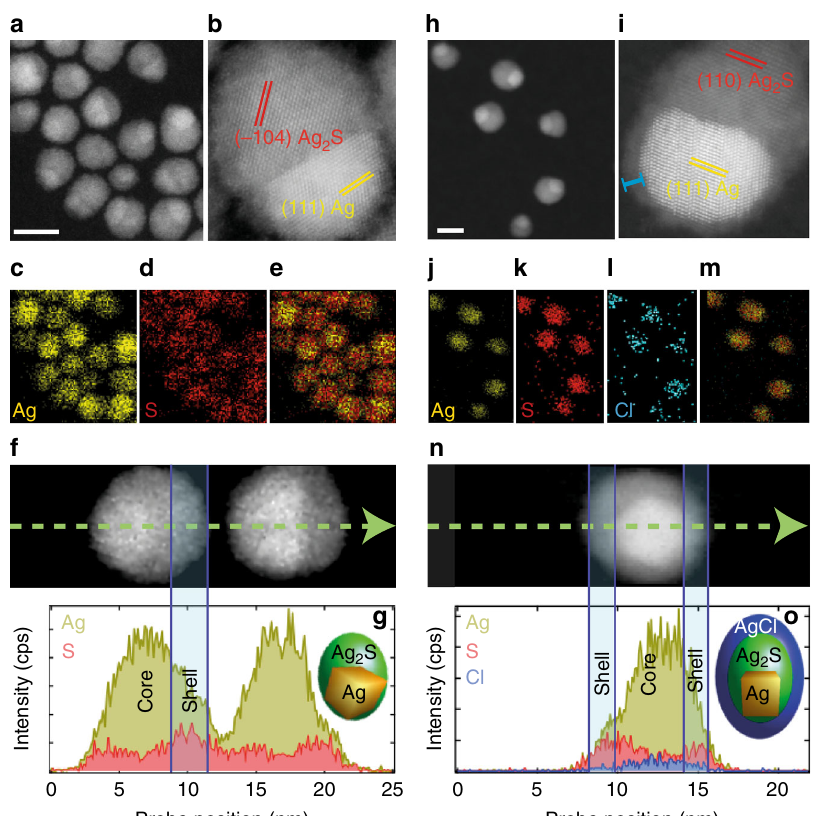
Fig. 1 Tuning structural and chemical properties through ultrafast laser irradiation. a HAADF-STEM micrograph of the as-synthesized Ag 2 S dots. Scale bar is 10 nm. b High-resolution STEM of as-synthetized dots showing lattice fringes d 111 and d − 104 of cubic Ag and monoclinic Ag 2 S, respectively. 2D EDS mapping of the spatial distribution of Ag ( c ), S ( d ), and Ag + S ( e ). f Magni fi ed STEM micrograph of two Ag 2 S dots. g Net X-ray intensity pro fi les extracted from the green arrow marked in f . Note how the Ag/S ratio increases at the edges of the dots, which coincides with the electro-dense area. The inset shows a model Ag 2 S dot. h HAADF-STEM micrograph of Ag 2 S dots after ultrafast laser irradiation with 50 fs laser pulses for 90 min at a power density of 9 W cm − 2 . Scale bar is 10 nm. i High-resolution STEM of an ultrafast laser-irradiated Ag 2 S dot showing lattice fringes d 111 and d 110 of cubic Ag and monoclinic Ag 2 S, respectively. Note the presence of a shell marked with a blue bracket around the nanoparticle. 2D EDS mapping of the spatial distribution of Ag ( j ), S ( k ), Cl ( l ), and Ag + S + Cl ( m ) of an ultrafast laser-irradiated Ag 2 S dot. n Magni fi ed STEM micrograph of an ultrafast laser-irradiated Ag 2 S dot. o Net X-ray intensity pro fi les extracted from the green arrow marked in image ( n ), where we can observe the presence of Ag, S, and Cl. The inset in o shows a schematic representation of a single Ag 2 S dot after ultrafast laser